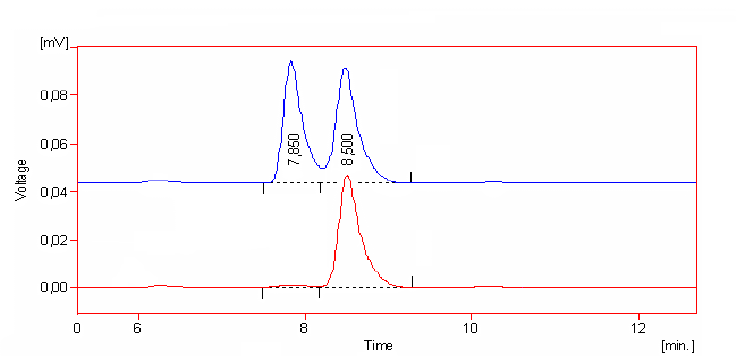
Figure 3. Chiral HPLC separation of the enantiomers of acetyl derivative 3 . Upper chromatogram represents separation of racemic mixture and lower the enantiomeric purity of the ( S )-enantiomer 3a (e.e. 94.6%). For separation conditions see